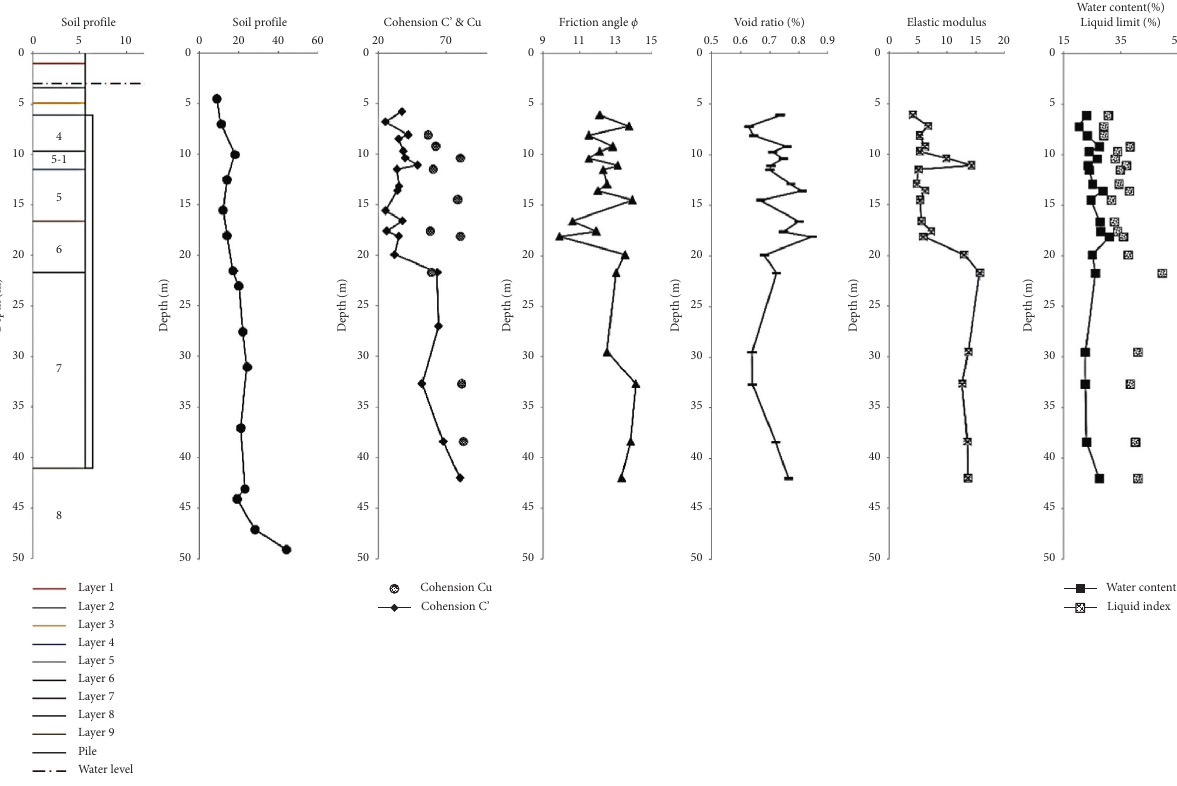
Figure 3: Subsurface conditions of